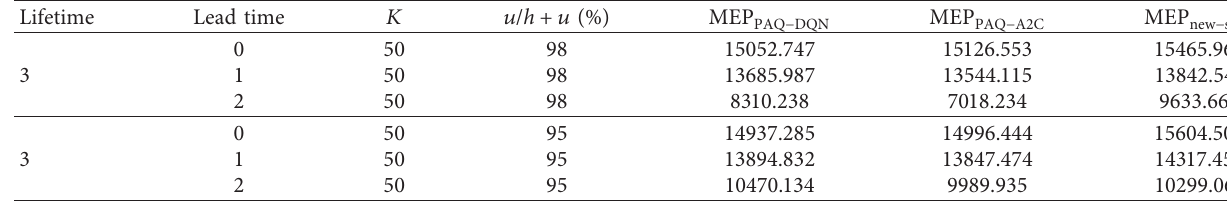
Table 9: MEP for new state forms.